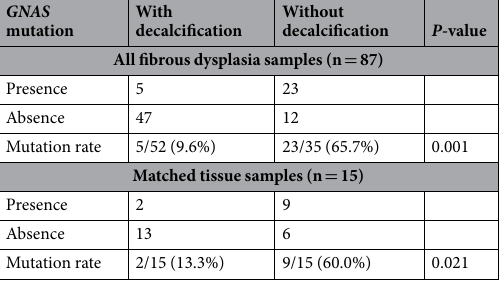
Table 2. Detection rate of GNAS mutation in tissue samples (with or without